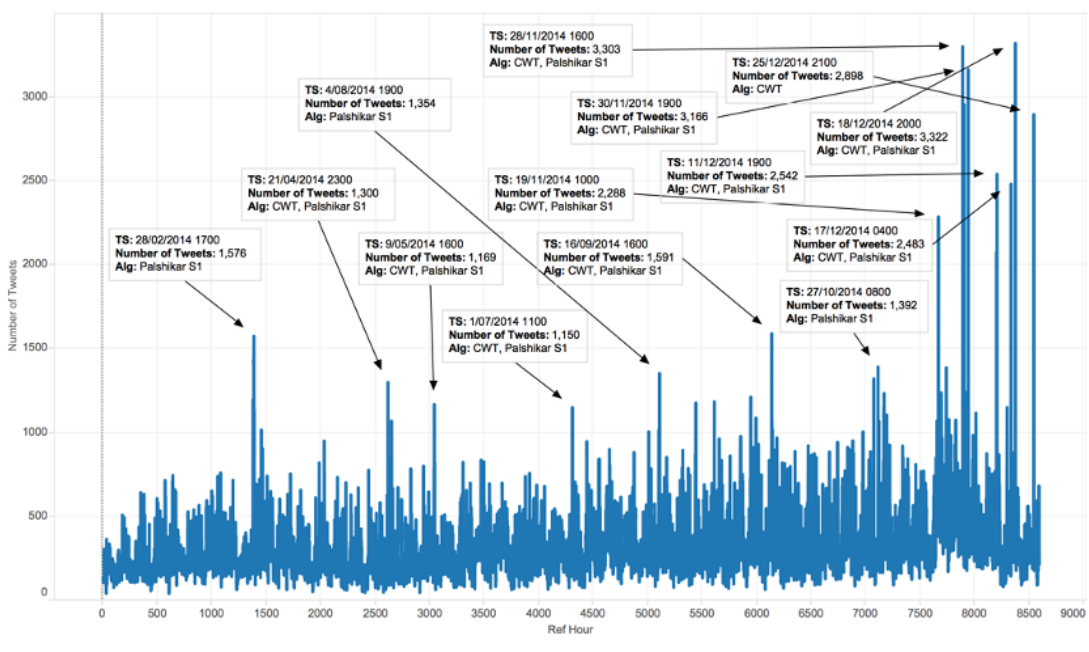
Figure 4. True Peaks